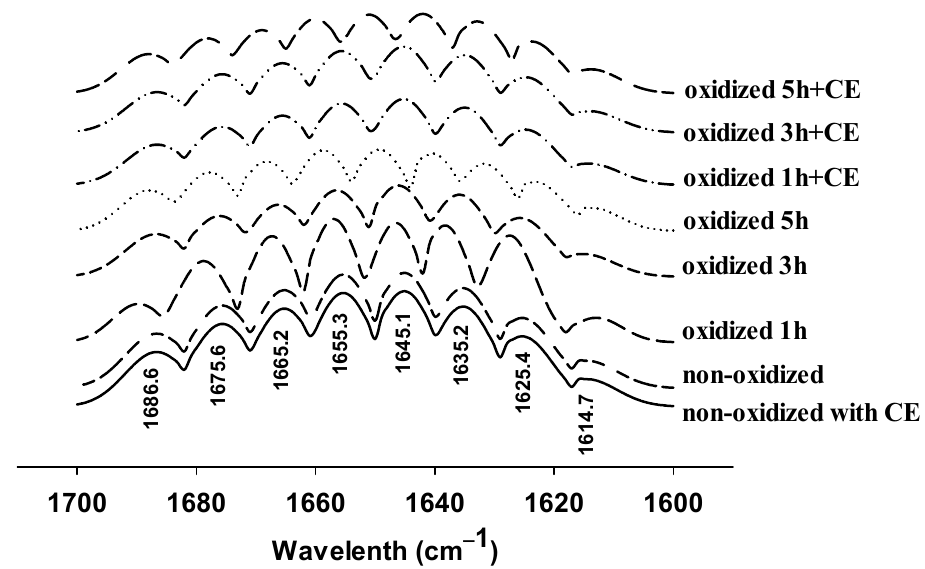
Figure 3. Influence of CE on Fourier transform infrared (FTIR) spectra of oxidized MPs during different oxidation times (0, 1, 3, and 5 h). Table 1. Influence of CE on secondary structure content of oxidized MPs during different oxidation times (0, 1, 3, and 5 h).